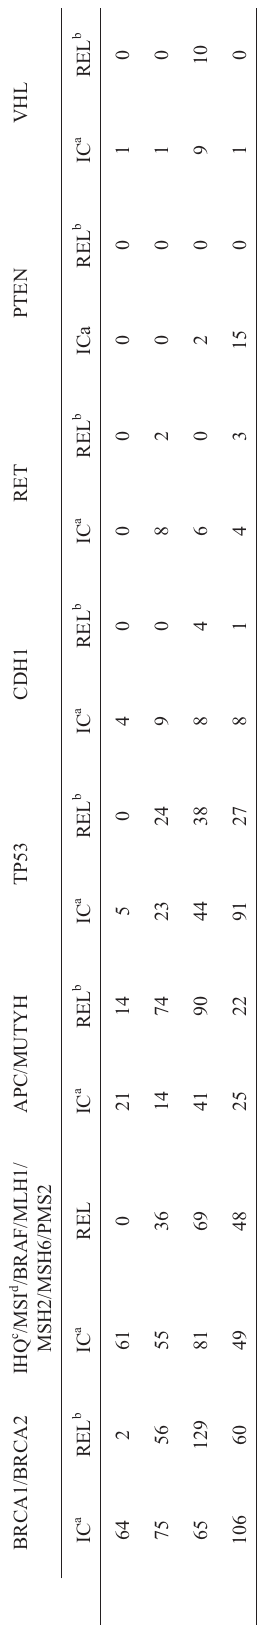
Figure 2 - Number of Genetic Counseling sessions of the Oncogenetics